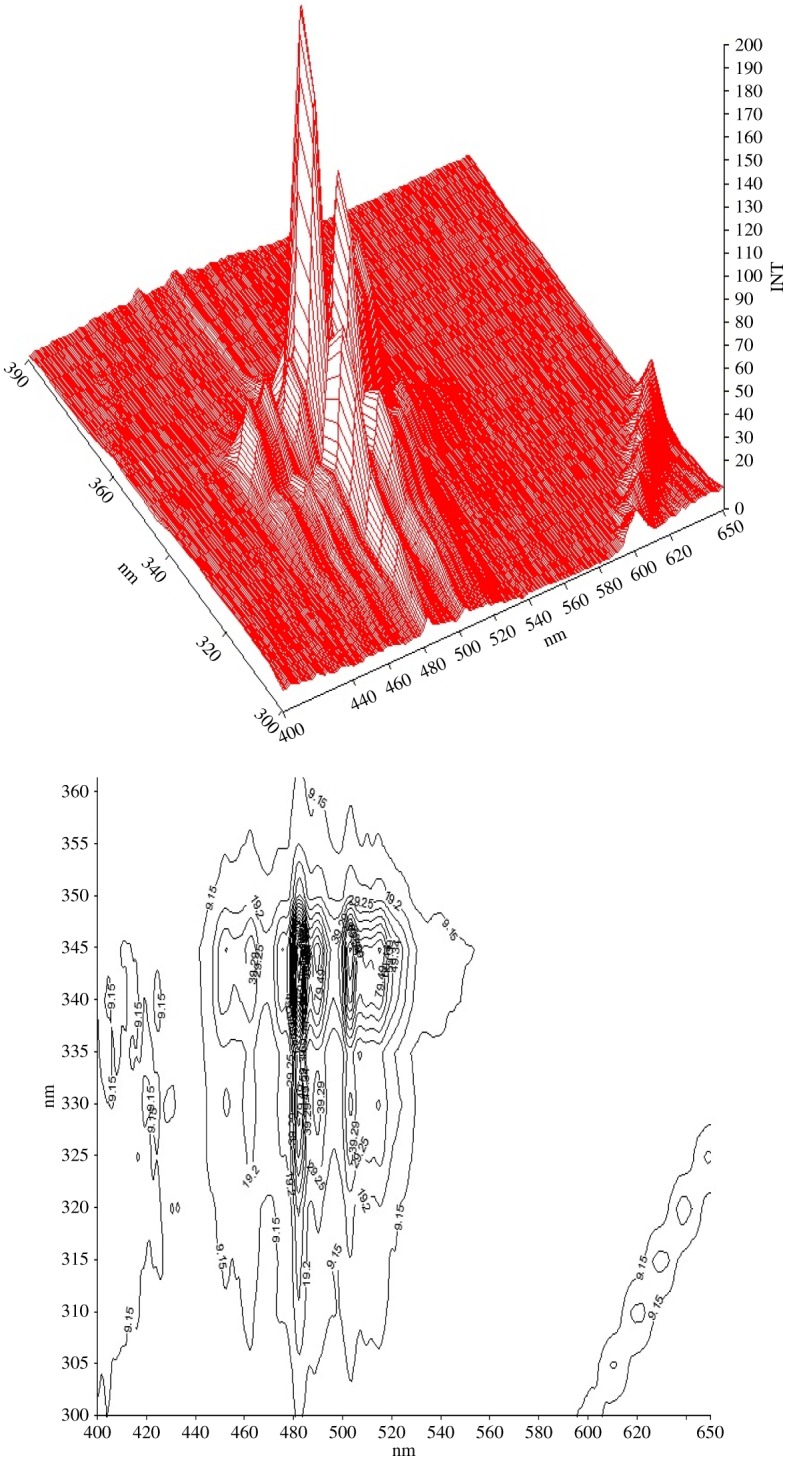
Effect of choice of Δλ on AML (2 µg ml−1). (INT, intensity)